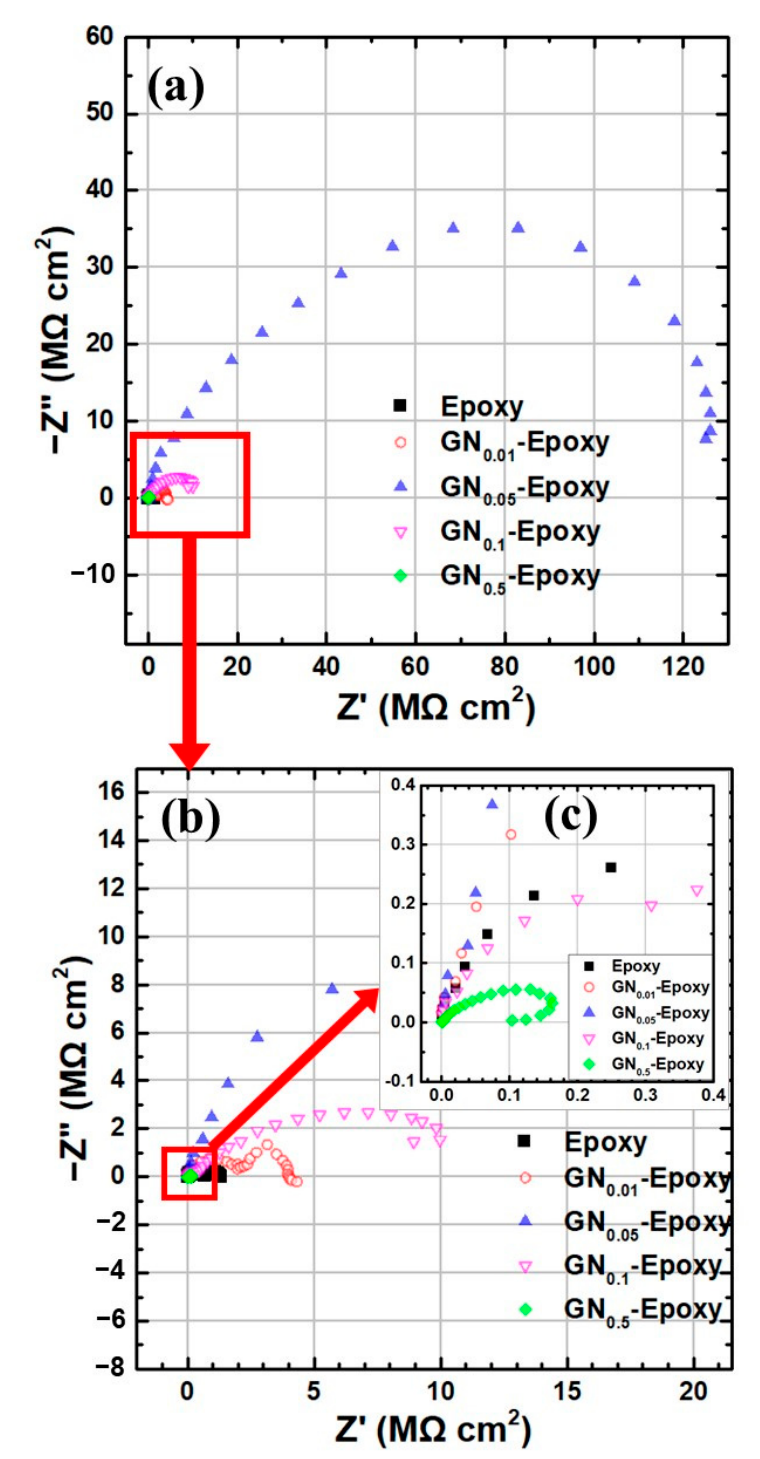
Figure 3. Nyquist plots of EIS for samples immersed in 3.5 wt.% NaCl solution. ( b , c ) are the successively magnified views of ( a